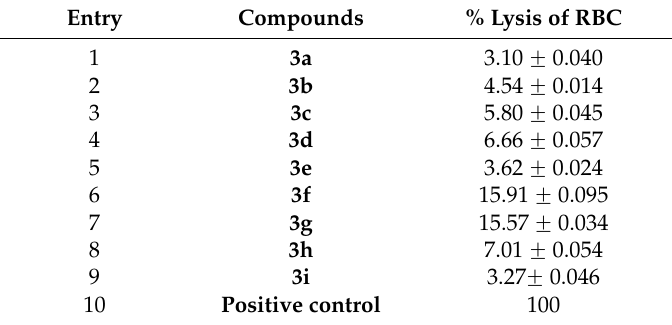
Table 4. The % lysis of RBCs data for newly-synthesized 2,5-biaryl-3-hexylthiophene derivatives ( 3a–i ).